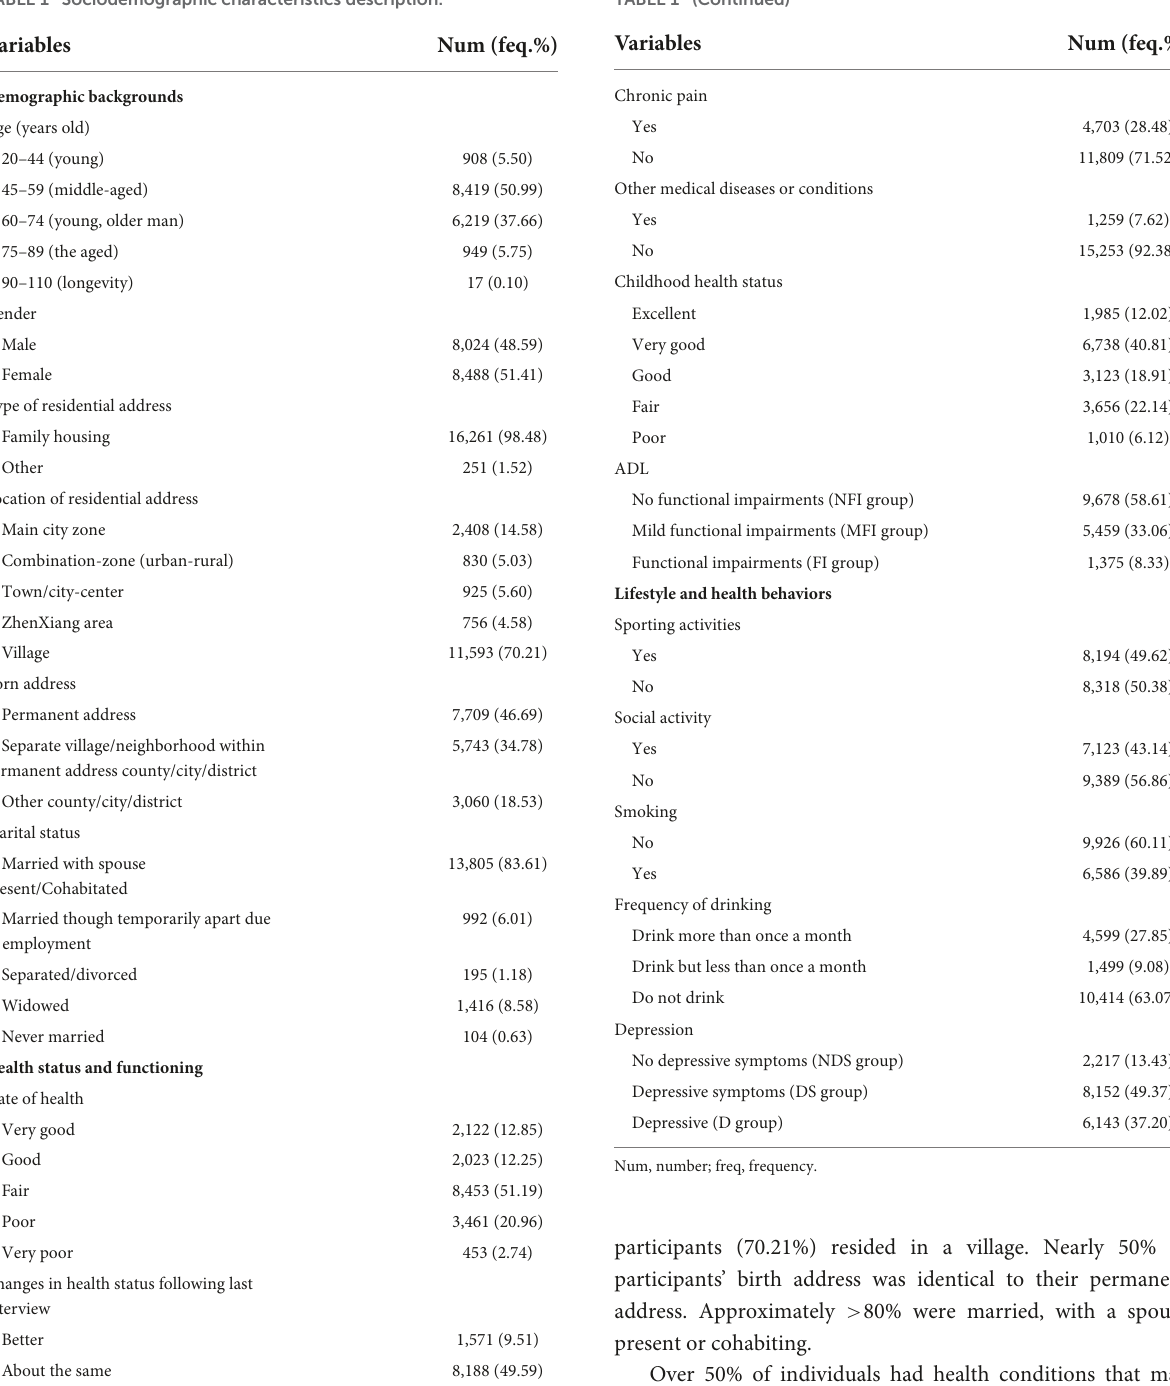
TABLE 1 Sociodemographic characteristics